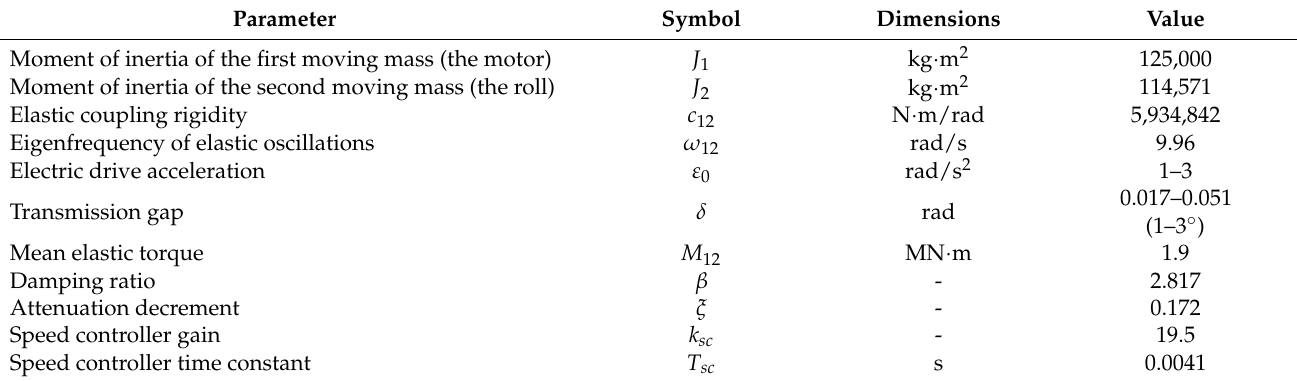
Table 1. Parameter of the two-mass system model, Mill 5000.